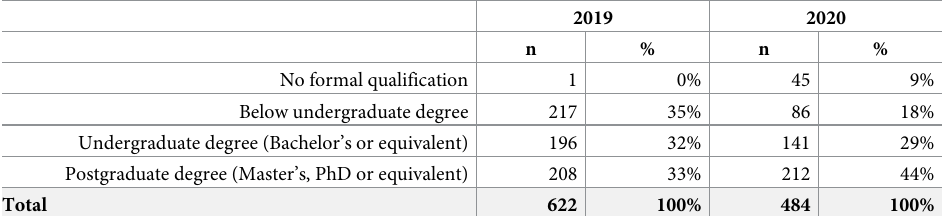
Table 4. Comparison of educational attainment of respondents across all event locations in 2019 &